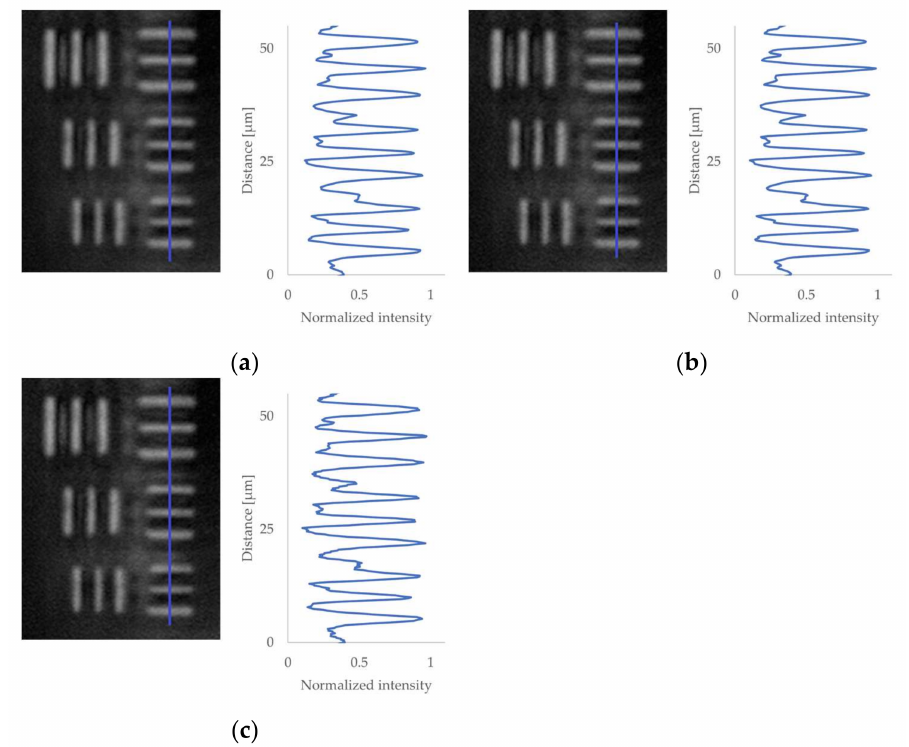
Figure 6. Magnified images of the reconstructed images obtained using the proposed technique when the interpolation algorithms were ( a ) bilinear, ( b ) bicubic, and ( c )